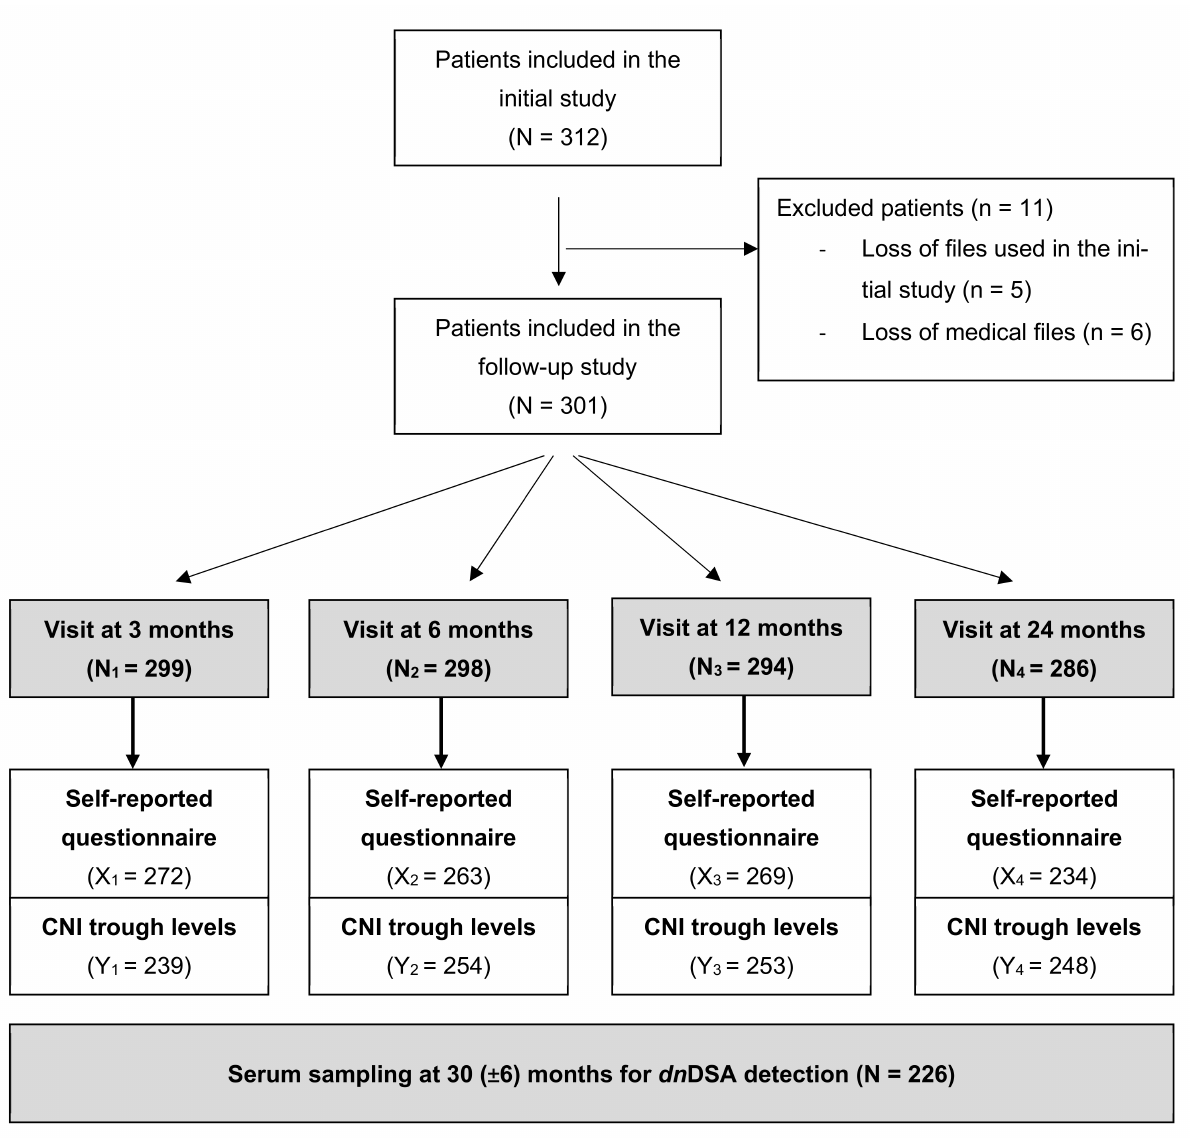
Figure 1. Study design flow chart. Patients completed adherence self-questionnaires at months 3, 6, 12, 24. CNI trough levels were collected retrospectively at months 3, 6, 12 and 24 ( ± 30 days). Serum samples were collected retrospectively between 2 and 3 years post transplantation for detecting dnDSA. At each visit, some data were available for N x patients. Among these N x patients, X x patients responded to the questionnaire and CNI through levels were available for Y x